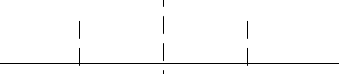
Figure 2. The local decision thresholds.